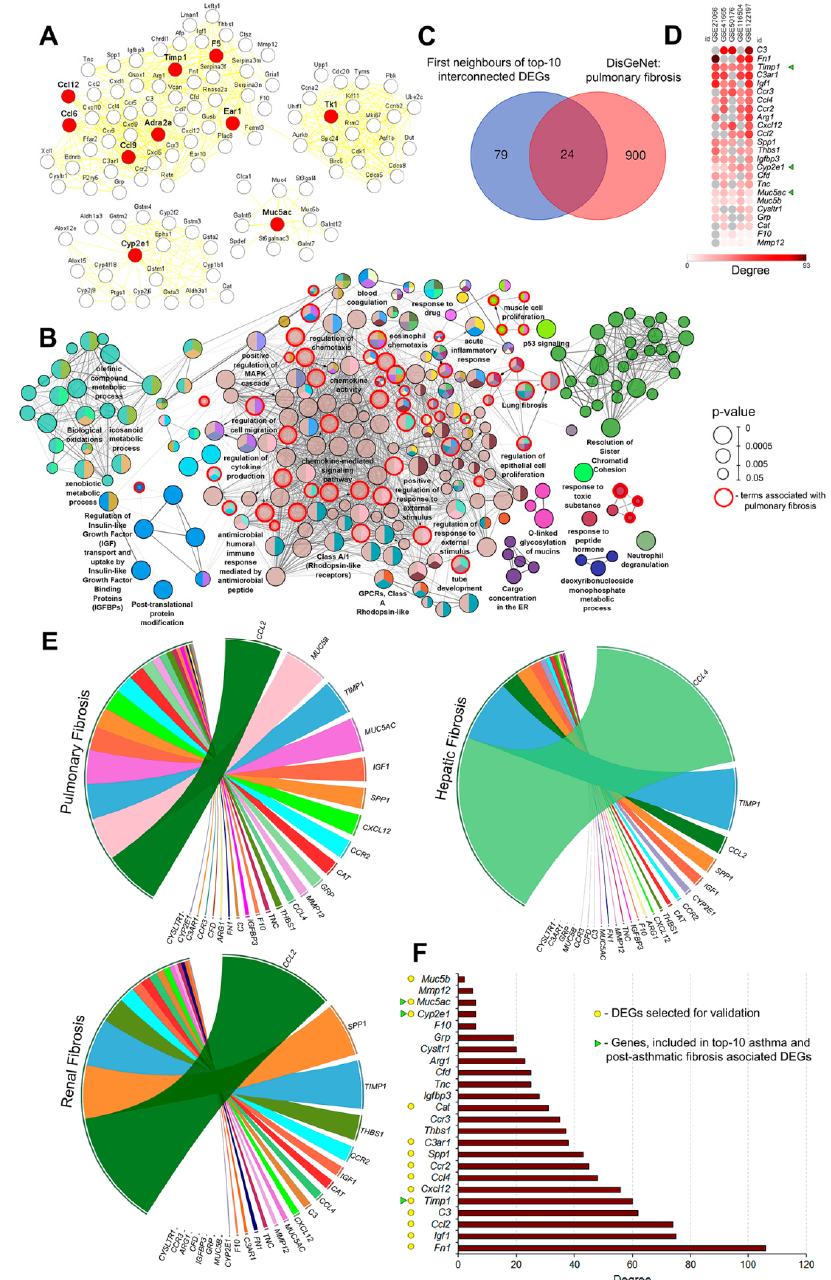
Figure 3. Involvement of key DEGs associated with OVA-induced asthma in the development of pulmonary fibrosis. ( A ) PPI network reconstruction for the top-10 interconnected DEGs with their first neighbors presented in at least three GSEs using STRING database (confidence score ≥ 0.7, maximal number of interactors = 0) in Cytoscape. ( B ) Functional analysis of top-10 interconnected DEGs with their first neighbors presented in at least three GSEs. Enrichment for Gene Ontology (biological processes), KEGG, REACTOME, and WikiPathways terms were performed using ClueGo plugin in Cytoscape. The labels of the most significant terms are shown. Color of nodes represents the term enrichment significance. Only pathways with p < 0.05 after Bonferroni step-down correction for multiple testing were included in the networks. Nodes with red boundaries indicate nodes related to fibrosis and lung remodeling. Different gene clusters are marked with different colors automatically. ( C ) Venn diagram demonstrating common genes between top-10 interconnected DEGs with their